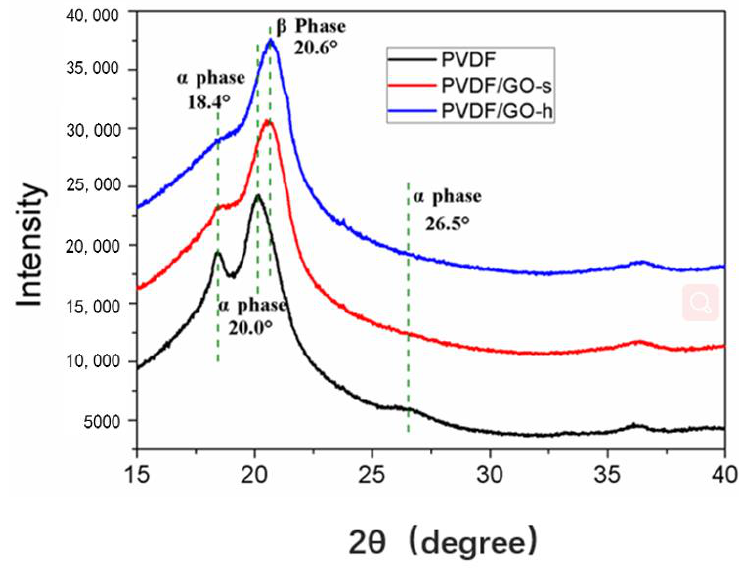
Figure 2. XRD spectra of PVDF, PVDF/GO-s and PVDF/GO-h membranes.